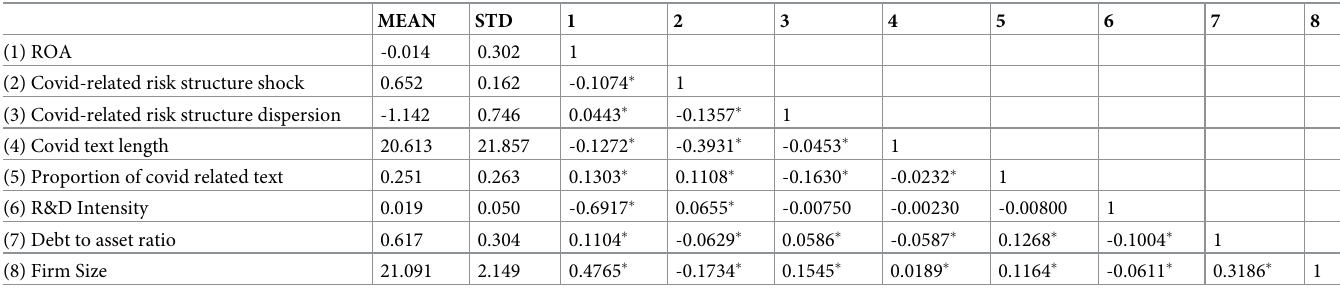
Table 1. Descriptive statistics and correlation table of major variables.